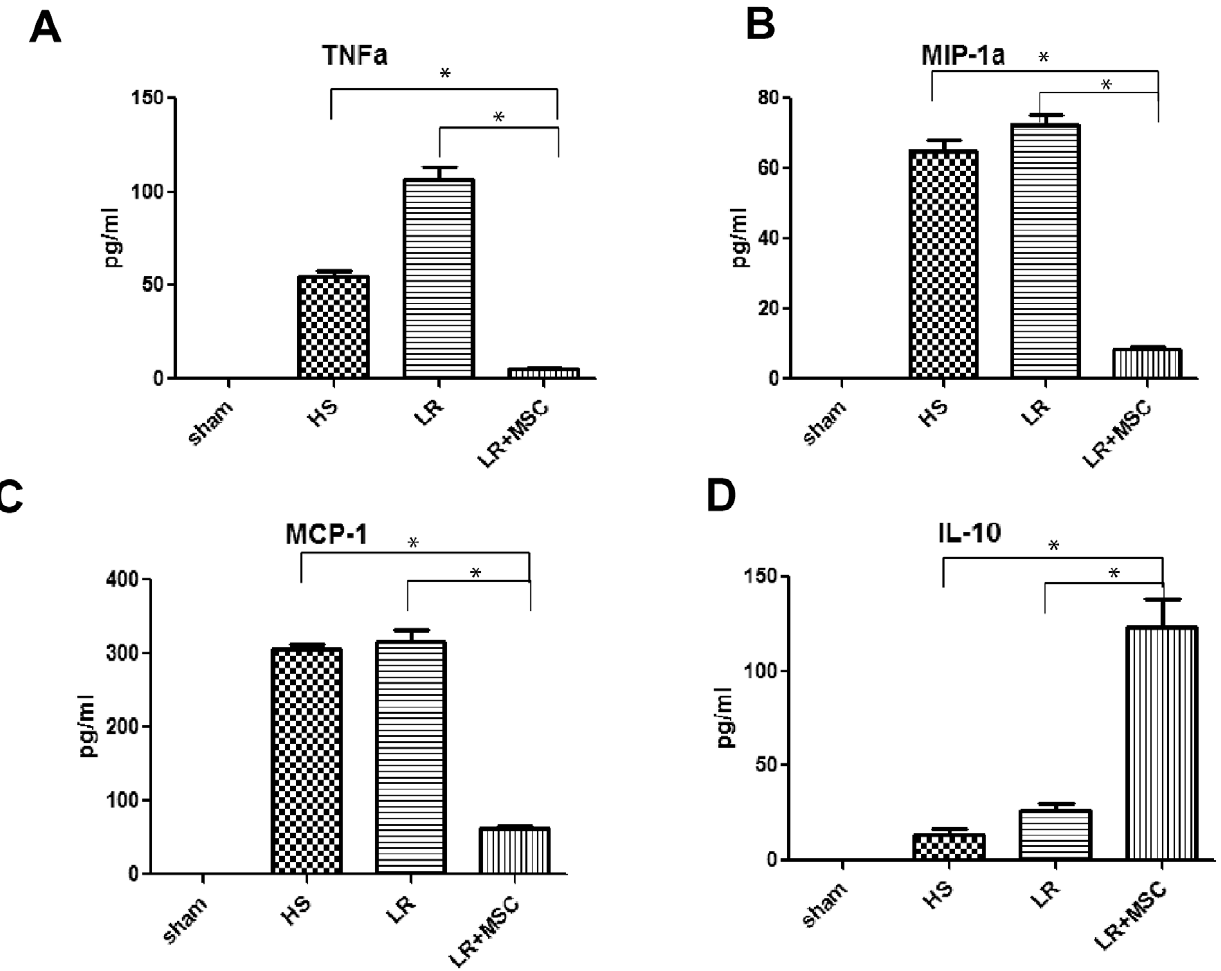
Figure 5. TNF a , MIP-1 a , and MCP-1 are decreased and anti-inflammatory cytokine IL-10 is increased by MSC treatment. Blood was drawn at two hours post-hemorrhage and analyzed for serum levels of TNF a , MCP-1, IL-10 and MIP-1 a . As shown in Figures 5A–C, bioplex analysis of serum shows that MCP-1, TNF a , and MIP-1 a all significantly increase after HS and HS + LR. This rise is significantly decreased by MSC administration (* indicates p , 0.05 for HS vs. LR + MSC and LR vs. LR + MSC). Figure 5D shows that anti-inflammatory cytokine IL-10 is significantly increased by MSC (Figure 5D).